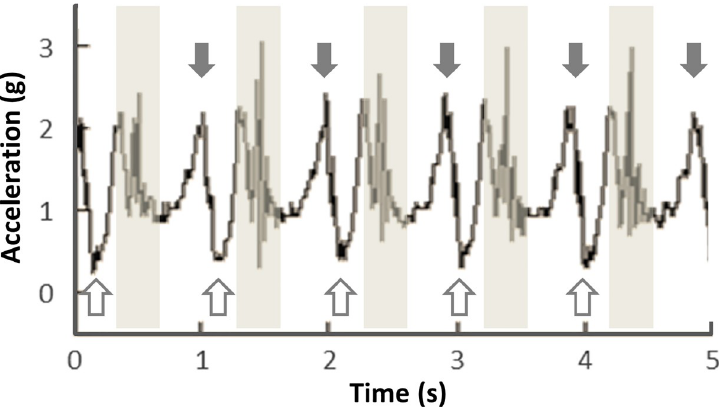
Fig 2. Example acceleration data extracted from a motion sensor. Peaks (filled arrows) represent the acceleration when the right foot was lifted, and the empty arrows represent the time during which the right foot was resting on the ground. The shaded areas show vibration noises that occurred when the right foot rested on the ground and the left foot was lifted.